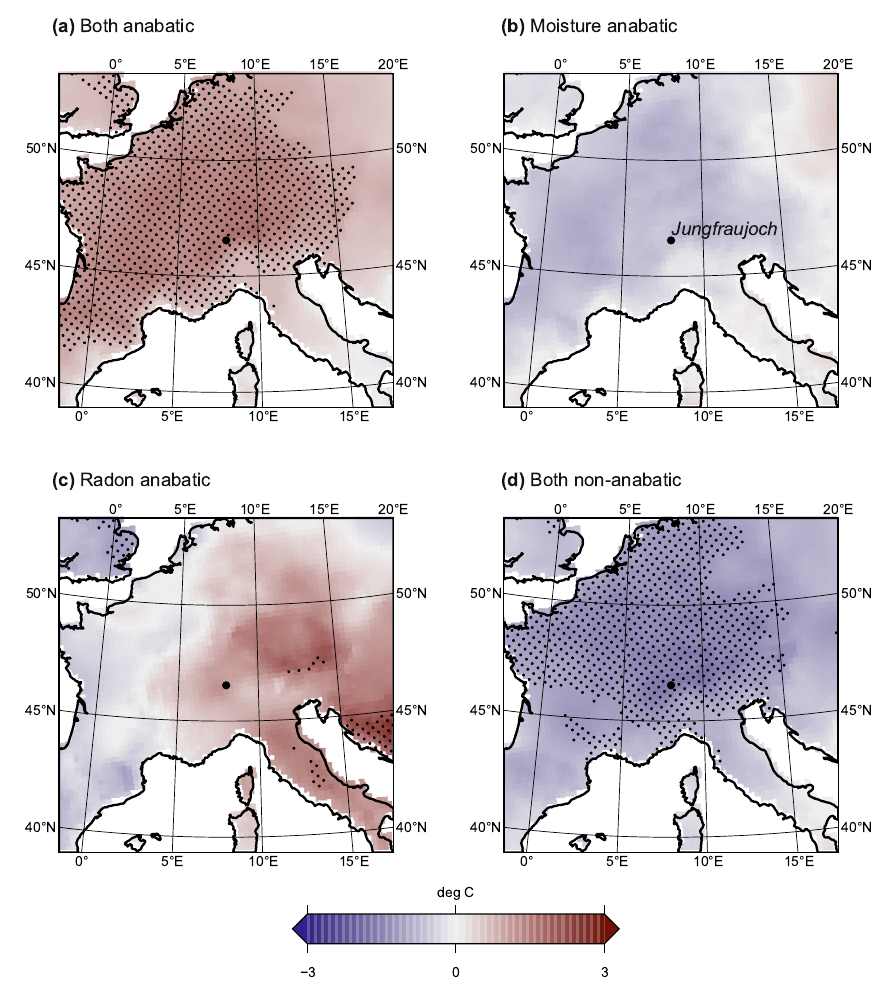
Figure 9. Daily maximum temperature anomalies for months with anabatic flows (April–September, inclusive) defined as the mean of each group minus the mean anomaly for all days with data available. The groups are: (a) days which are anabatic according to both radon and r , 140 samples; (b) anabatic days according to r but not radon, 68 samples; (c) anabatic days according to radon but not r , 73 samples; and (d) non-anabatic days according to both tracers, 82 samples. The stippled region indicates a statistically significant difference between the group mean and the full population at the 95% confidence level according to Welch’s t test (Press et al., 2007; Welch, 1947). Data are gridded observations from E-OBS (Haylock et al.,